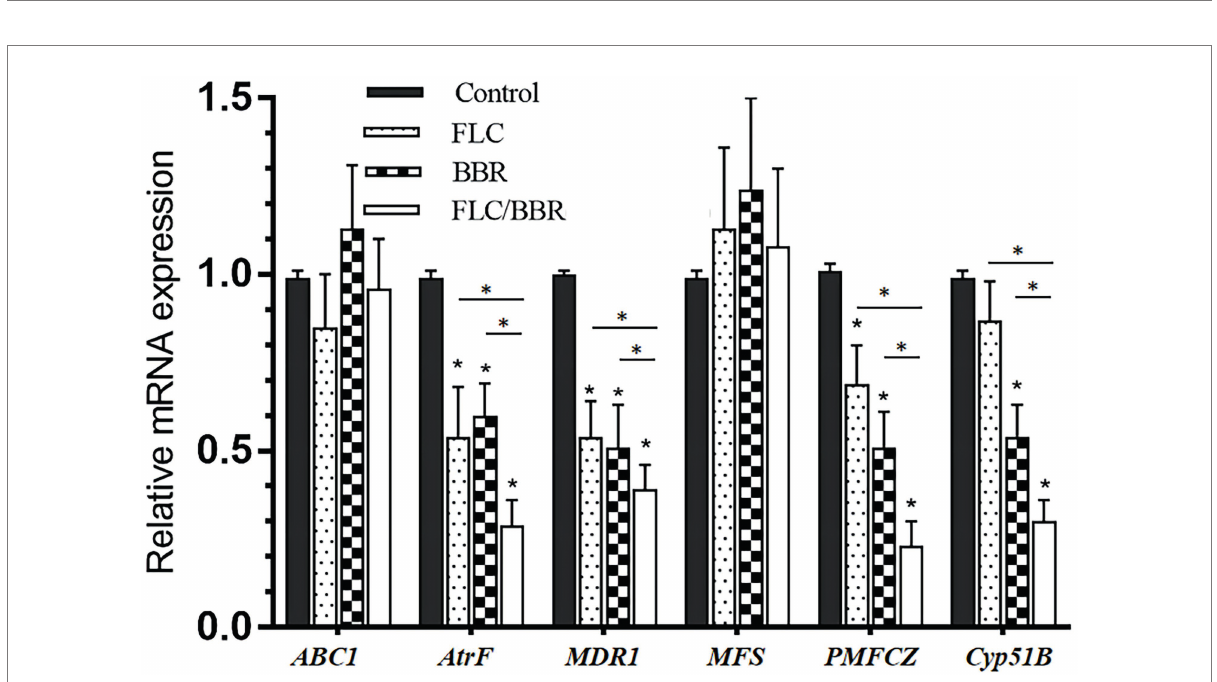
FIGURE 7 Gene expressions of ABC1,AtrF, Mdr1,MFS, PMFCZ and Cyp51B in TM (B4) under treatments. * p < 0.05 compared with the